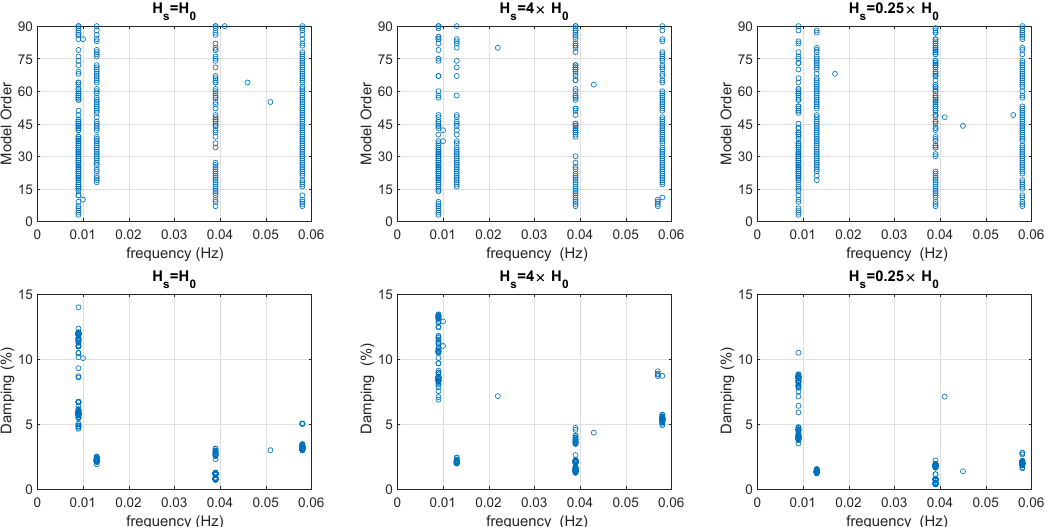
Figure 7. Stabilization and damping diagrams for the different wave